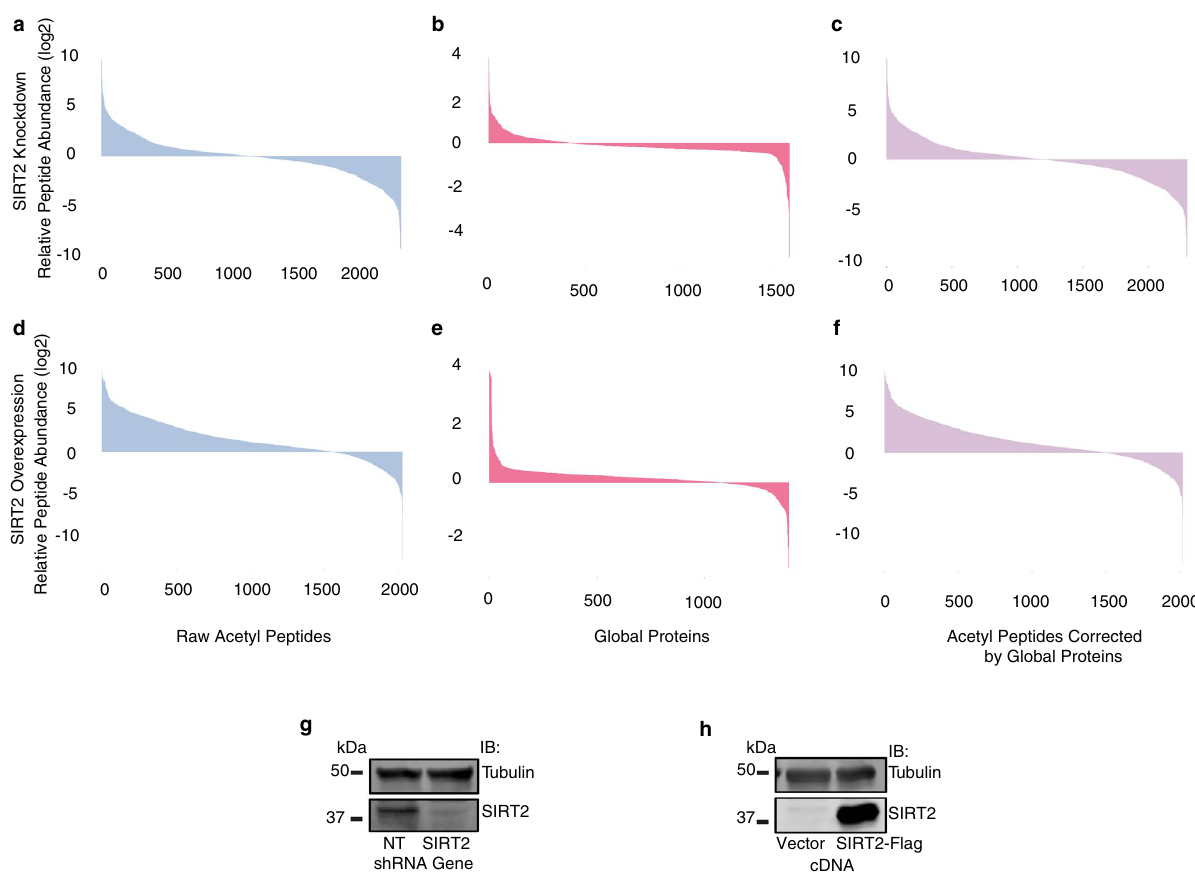
Figure 1. Proteome-wide identification of lysine acetylation following SIRT2 knockdown and overexpression. ( a – f ) represent respectively relative peptide abundance of acetyl peptides, global proteins, and acetyl peptides corrected by global proteins with SIRT2 knockdown ( a – c ) or overexpression ( d – e ). ( g – h ) Representative western blot analysis showing SIRT2 knockdown ( g ) or overexpression ( h